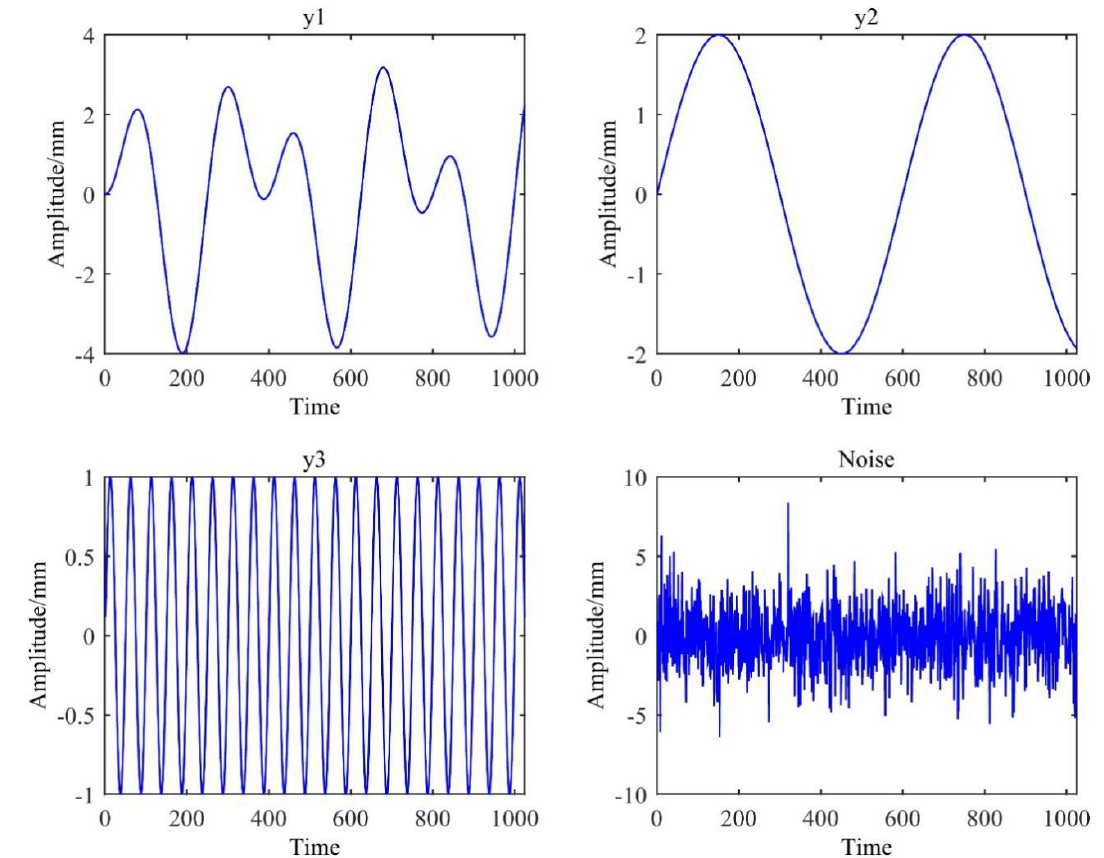
Figure 10. Four signal components of simulation data I.